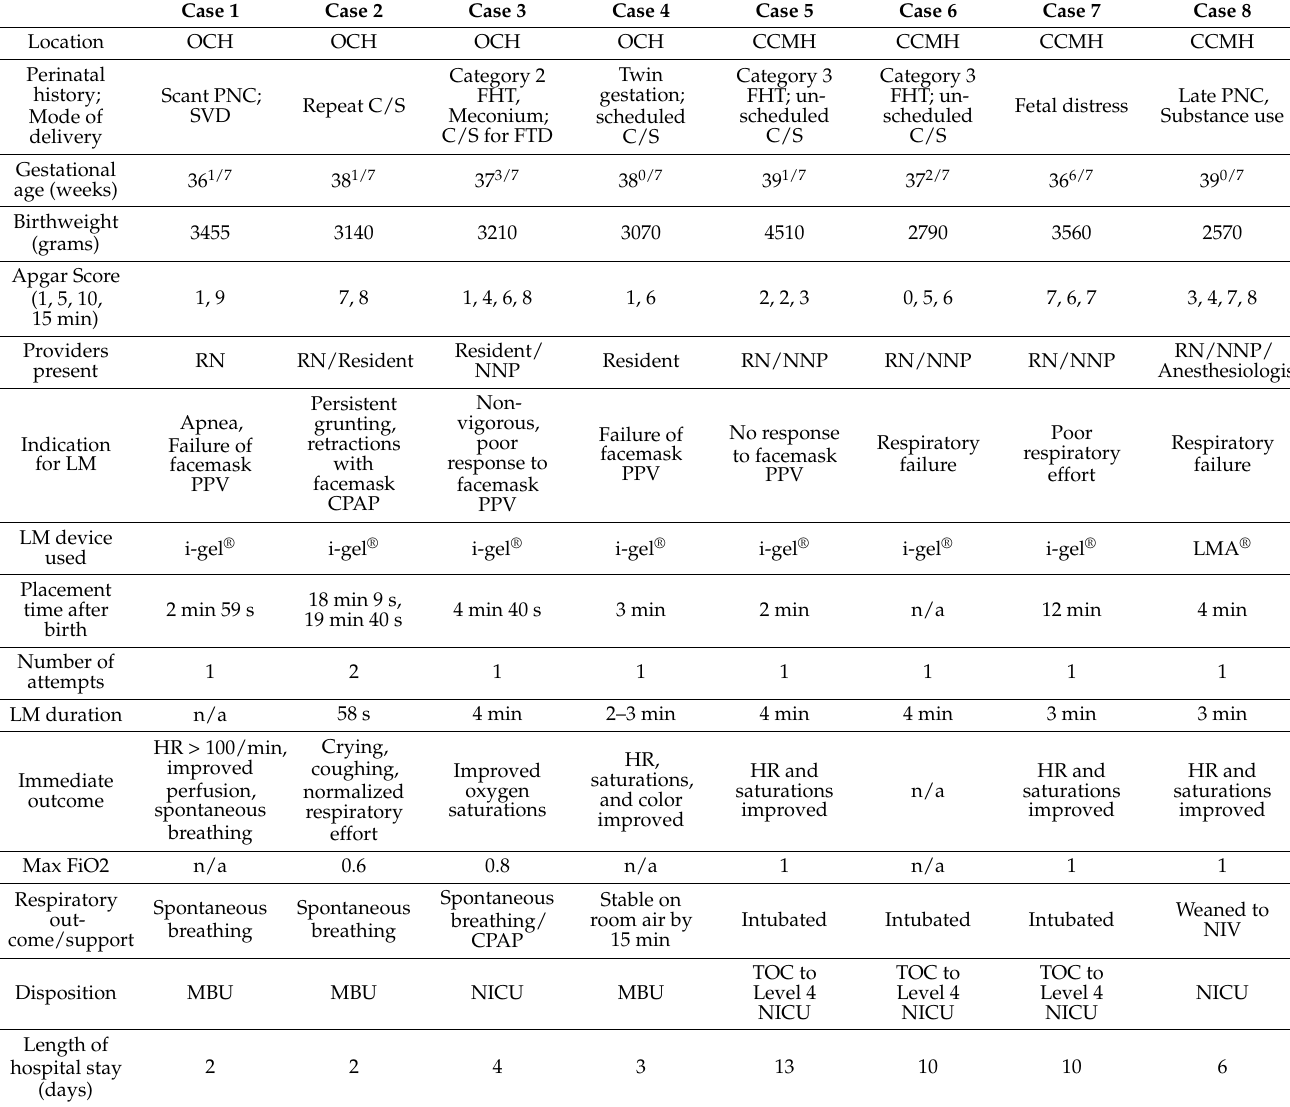
Table 1. Characteristics of Infants Receiving Laryngeal Mask Intervention in the Delivery